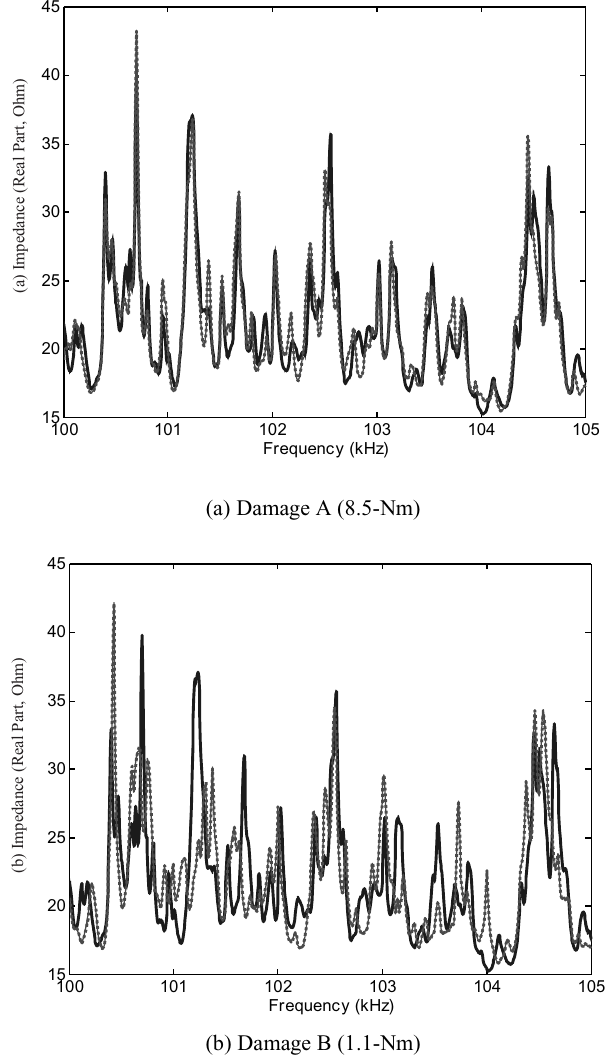
Fig. 15. The Impedance (Real Part) Measurement for P2 for Two Connection-type Damage Cases (Solid Line: Baselines, Dotted line: Damage) (a) Damage 1 (8.5-Nm); (b) Damage 1